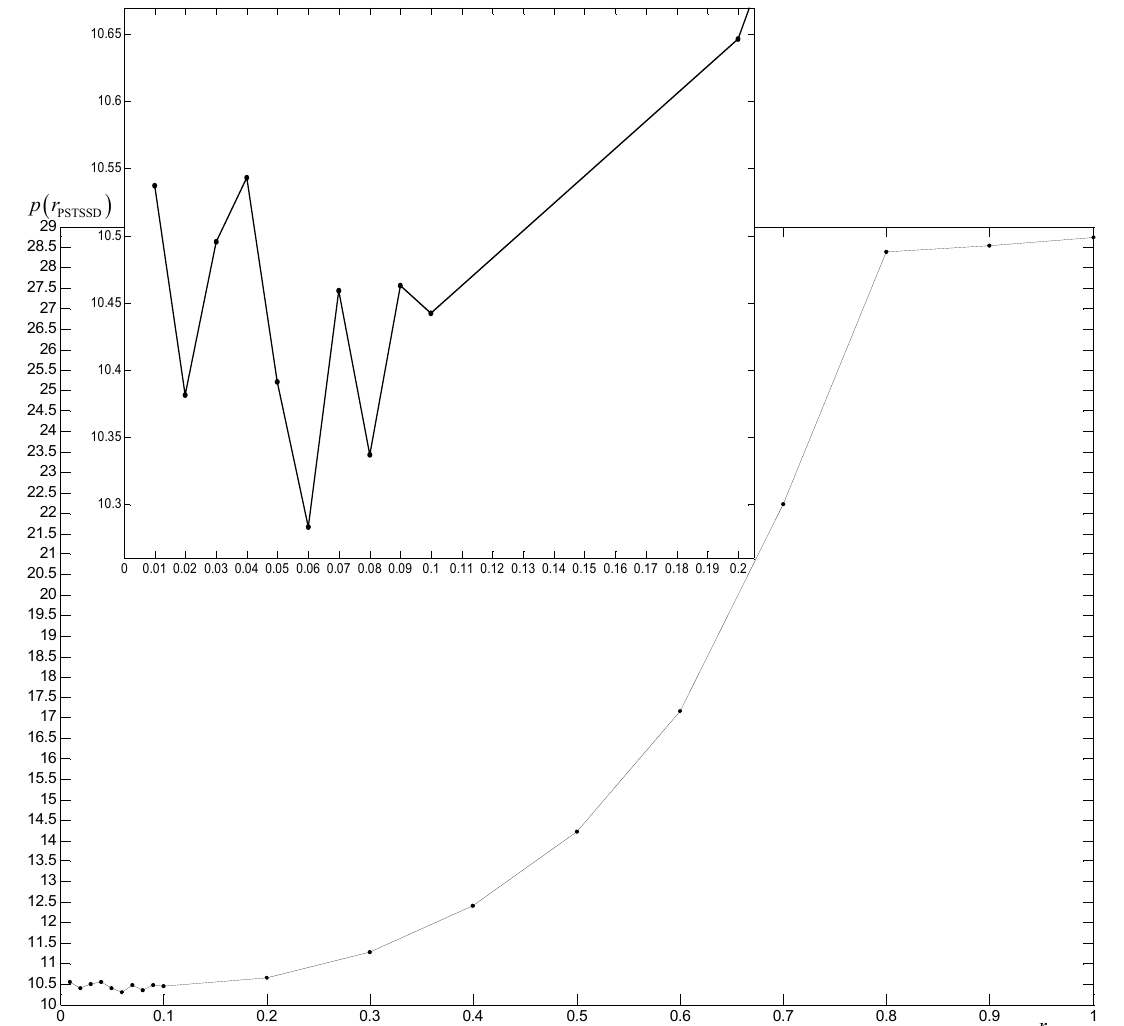
Fig. 1. An evaluation of function (8) for 2LP (22) on the 19-pointed subset (27). Each point is the average of 40 2LPs. A view of solving problem (23) is